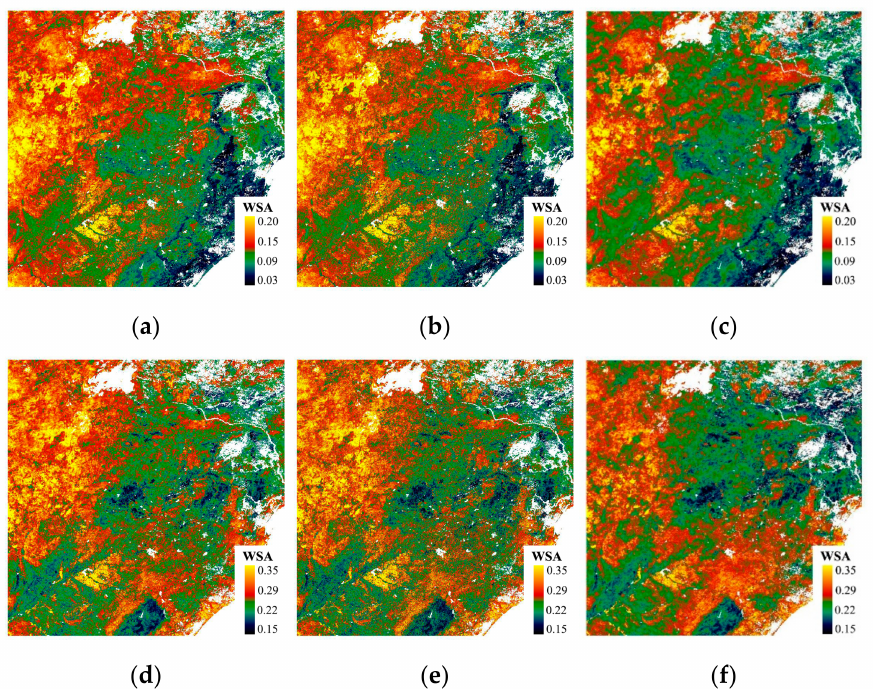
Figure 14. Same as Figure 13, but for MODIS observation within 2021.305-320. ( a – c ) refer to the red band albedo; ( d – f ) refer to the NIR band albedo; ( a , d ) refer to the albedo retrieval from multi-angular observations; ( b , e ) refer to a single directional reflectance; and ( c , f ) refer to the MODIS albedo.